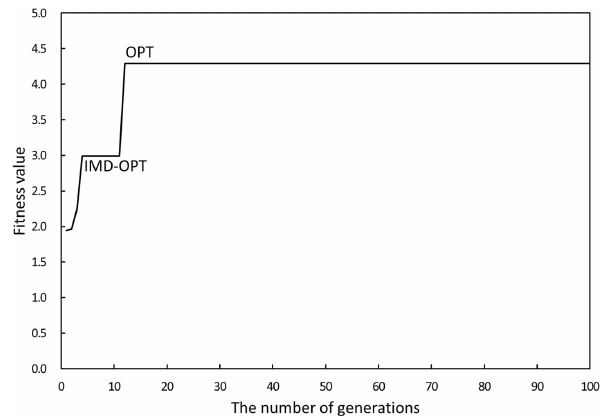
Figure 3. Evolution of generations in the optimization process, leading to changes in fitness values. OPT and IMD-OPT represent the final optimized phase and one of the intermediate optimized phases,